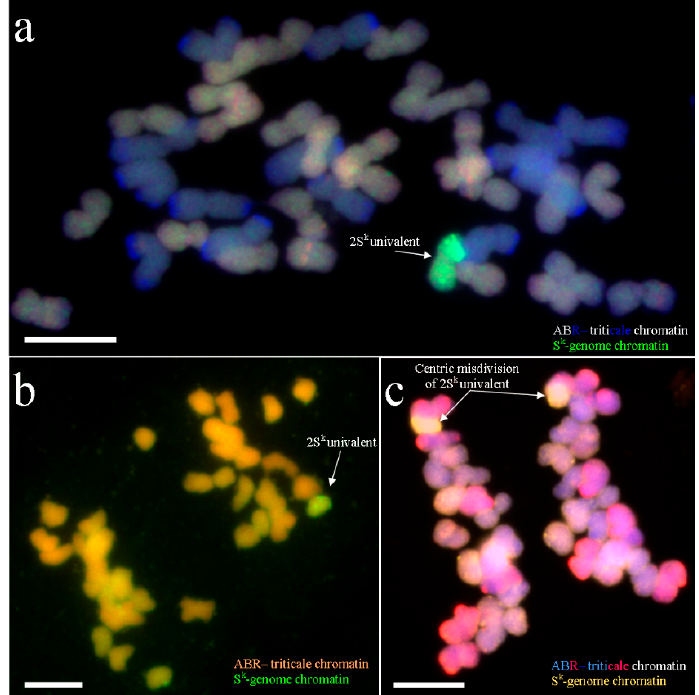
Figure 2. ( a ) Chromosome set of a 40 + M2R + M2S k triticale plant ( b ) Segregation of chromosome 2S k (green, Atto-488) at anaphase I in a 40 + M2R + M2S k triticale plant. ( c ) Centric misdivision of chromosome 2S k (yellow, Atto-647) at anaphase I in a 40 + M2R + M2S k triticale plant. Scale bar, 10 µ